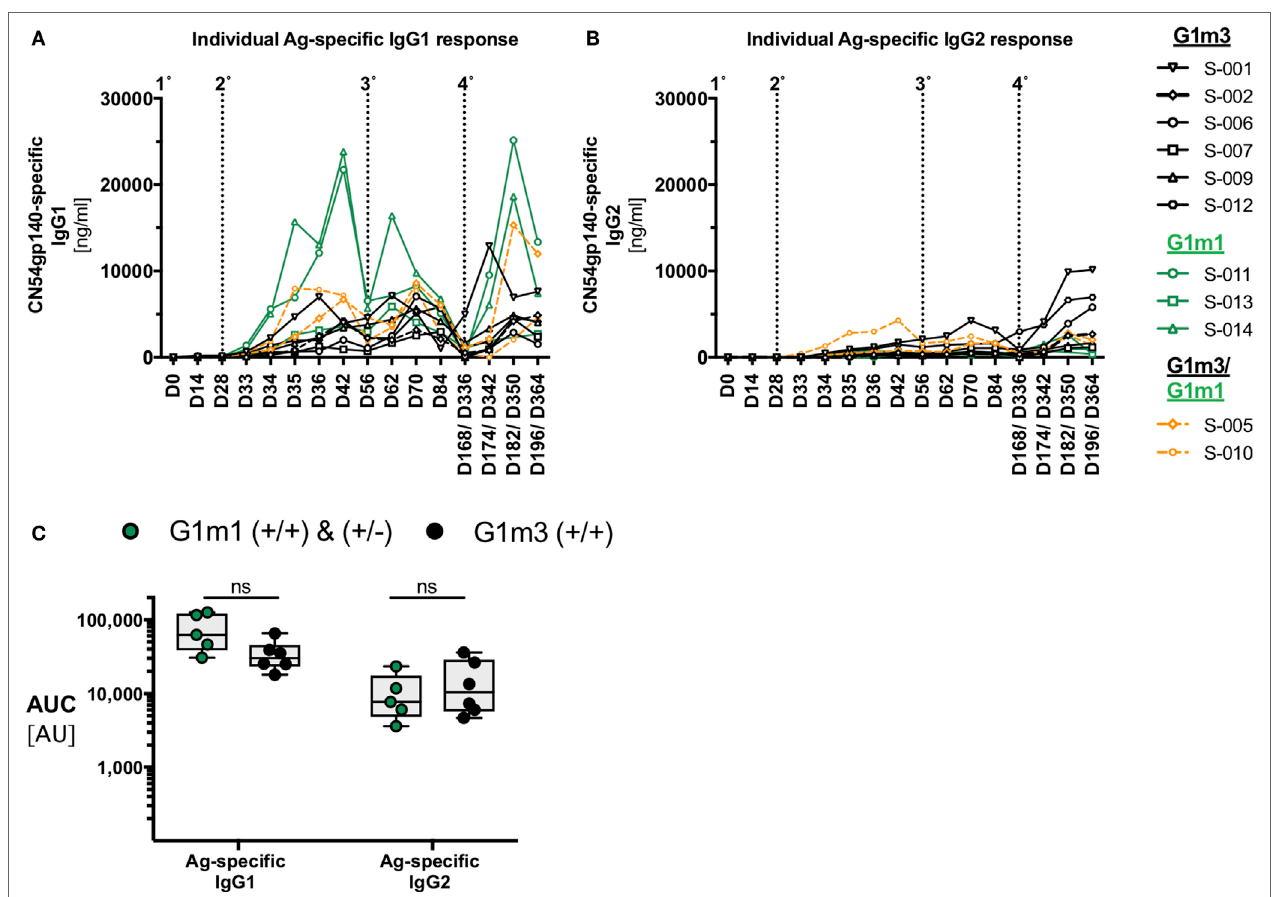
FigUre 2 | Individual antigen-specific IgG-subclass responses in the context of IgG1-allotypes. IgG-subclasses responses, classified with respect to G1m3 and/or G1m1 allotypes. (a) Individual Ag-specific IgG1-responses (participant IDs are shown in the legend on the right). (B) Individual Ag-specific IgG2-responses. (c) Area under curve (AUC) analysis for Ag-specific IgG1/IgG2 responses across all study time-points. Non-parametric Mann–Whitney